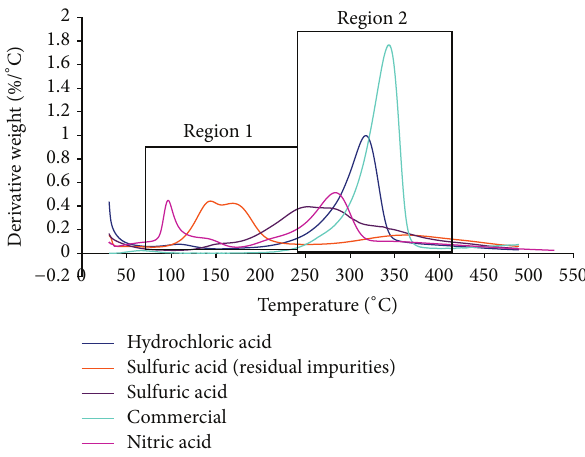
Figure 6: Revealing the thermogravimetric analysis derivative curves for cMCC and cellulose extracted using acid hydrolysis